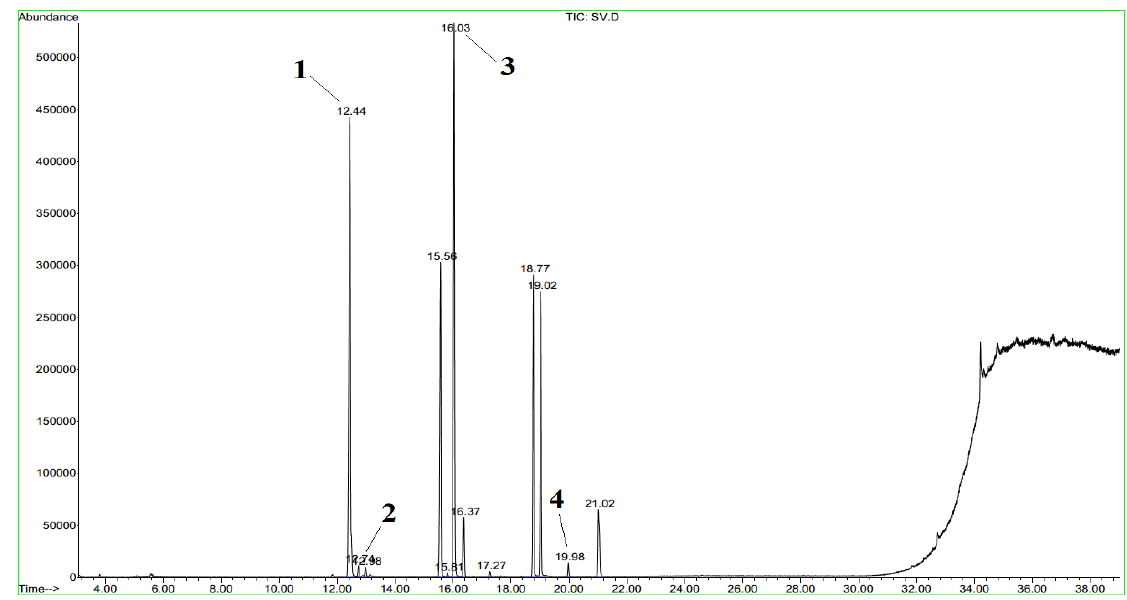
Fig. 3. GC/MS chromatogram of free carbohydrates in Agrimonia eupatoria L.